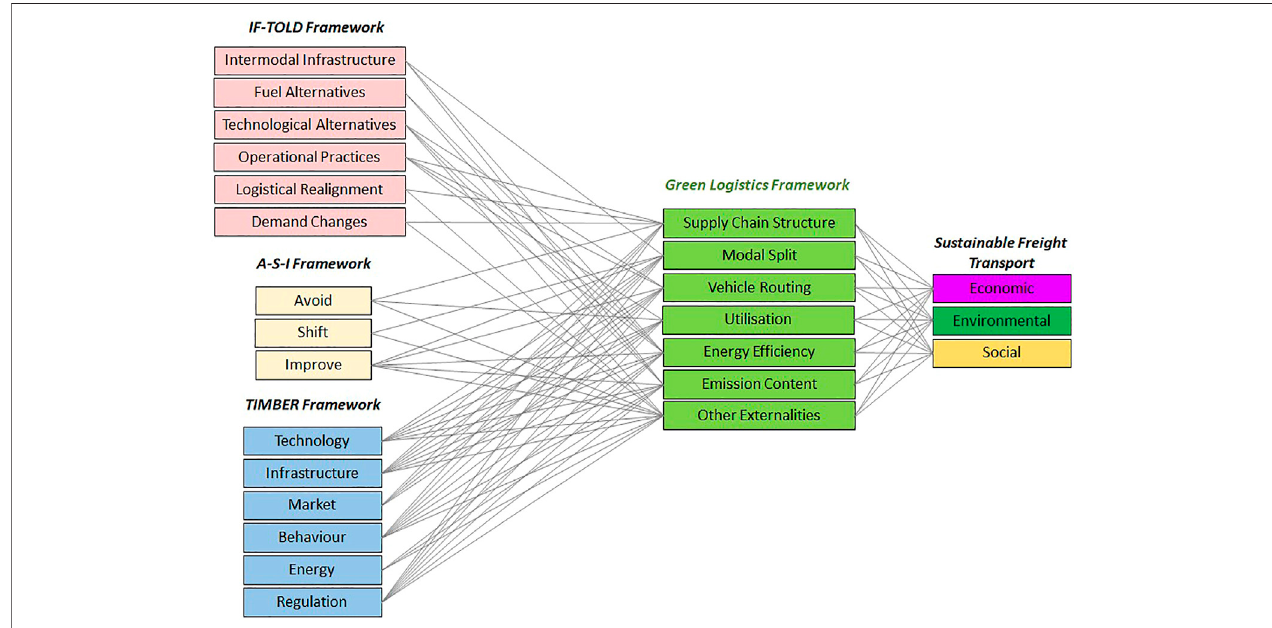
FIGURE7| Interrelationship between Sustainable Freight Transport, and ASI,GreenLogistics, TIMBER, and IF-TOLDframeworks (Authors ’ conceptionbased on United Nations Conference on Trade and Development, 2017; Mckinnon, 2018).